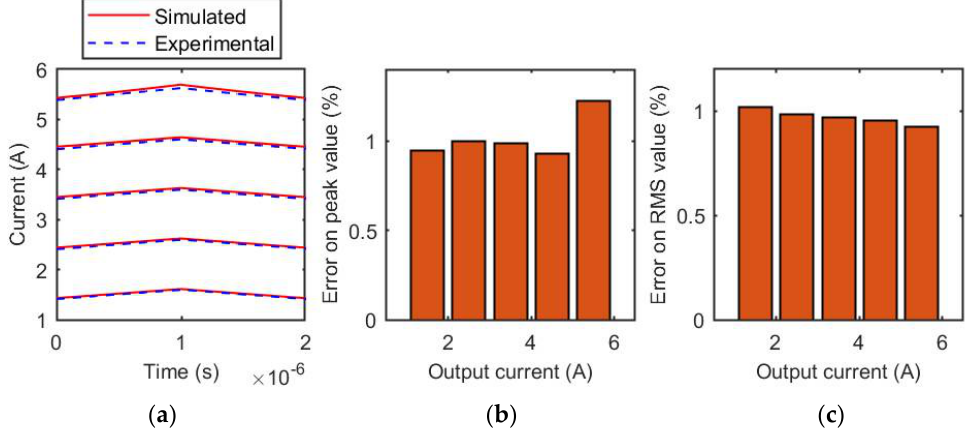
Figure 15. Coilcraft SER1390-333 inductor, 12 V. ( a ) Comparison of experimental and simulated current waveforms for different output current values; ( b ) relative error of the estimation of the peak value of the inductive current for each tested output current value; ( c ) relative error of the estimation of the RMS value of the inductive current for each tested output current value.